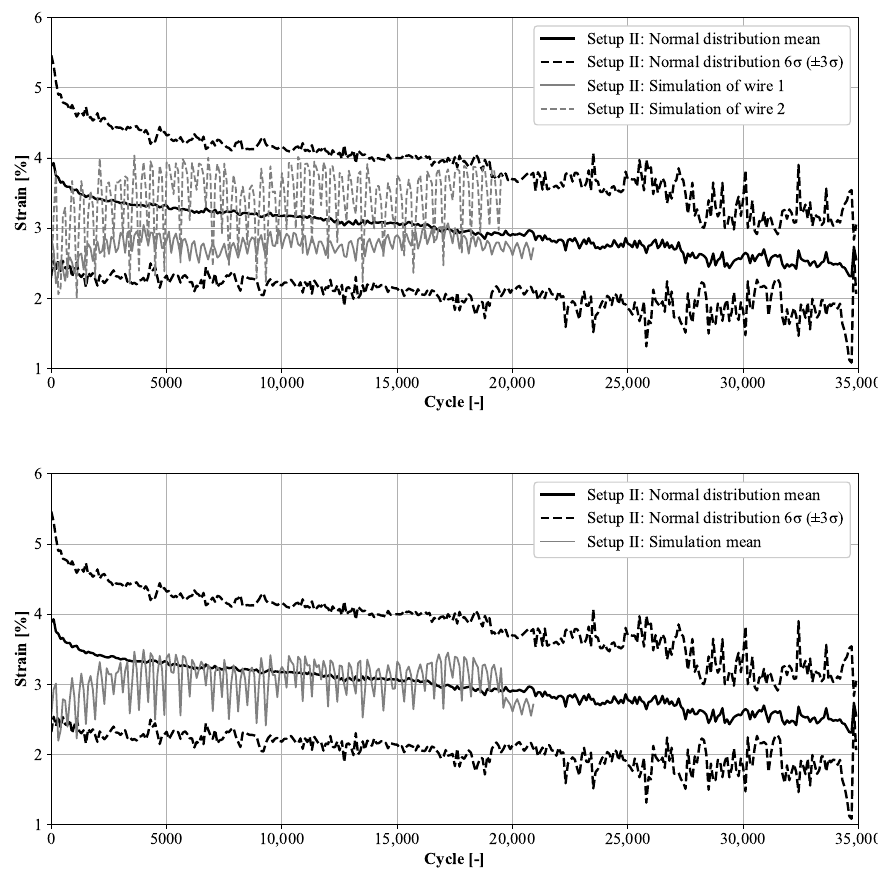
Figure 15. Target model for setup II based on the fatigue tests: Comparison of target model and 2 simulated wires ( Top ); Comparison of target model and the mean of the simulation ( Bottom